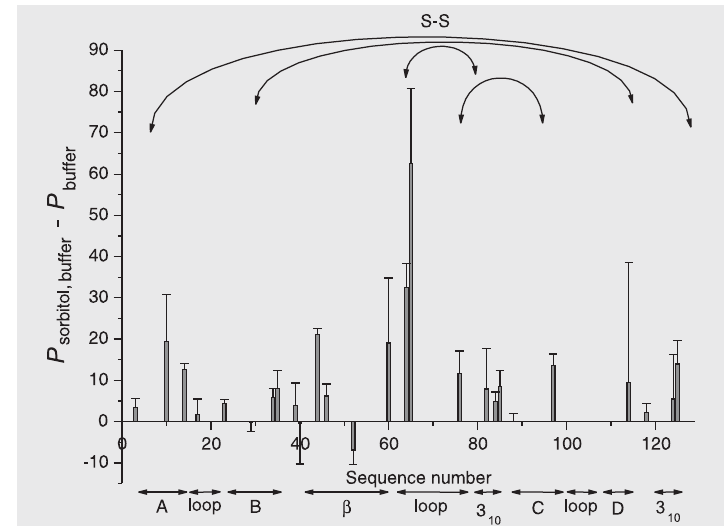
Figure 5. Differences in P -factors, ∆ P = P sorbitol, buffer - P buffer , upon pressure-assisted cold denaturation of hen egg white lysozyme in the presence and absence of 500 mM sorbitol. Addition of sorbitol led to a drastic increase of P -factors. For other explana- tions, see legend to Figure 2.